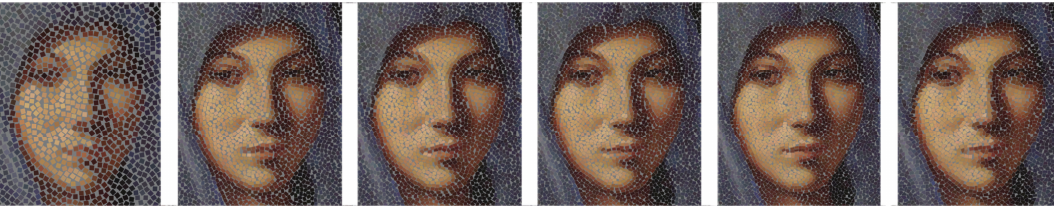
Figure 9: Examples of mosaics obtained by using both subtractive and shared cuts with 𝑇 𝑁 ranging from 0% (no cut) to 50% (step of 10%), 𝑅 fixed to 1 = 2 𝑅 𝑁 and